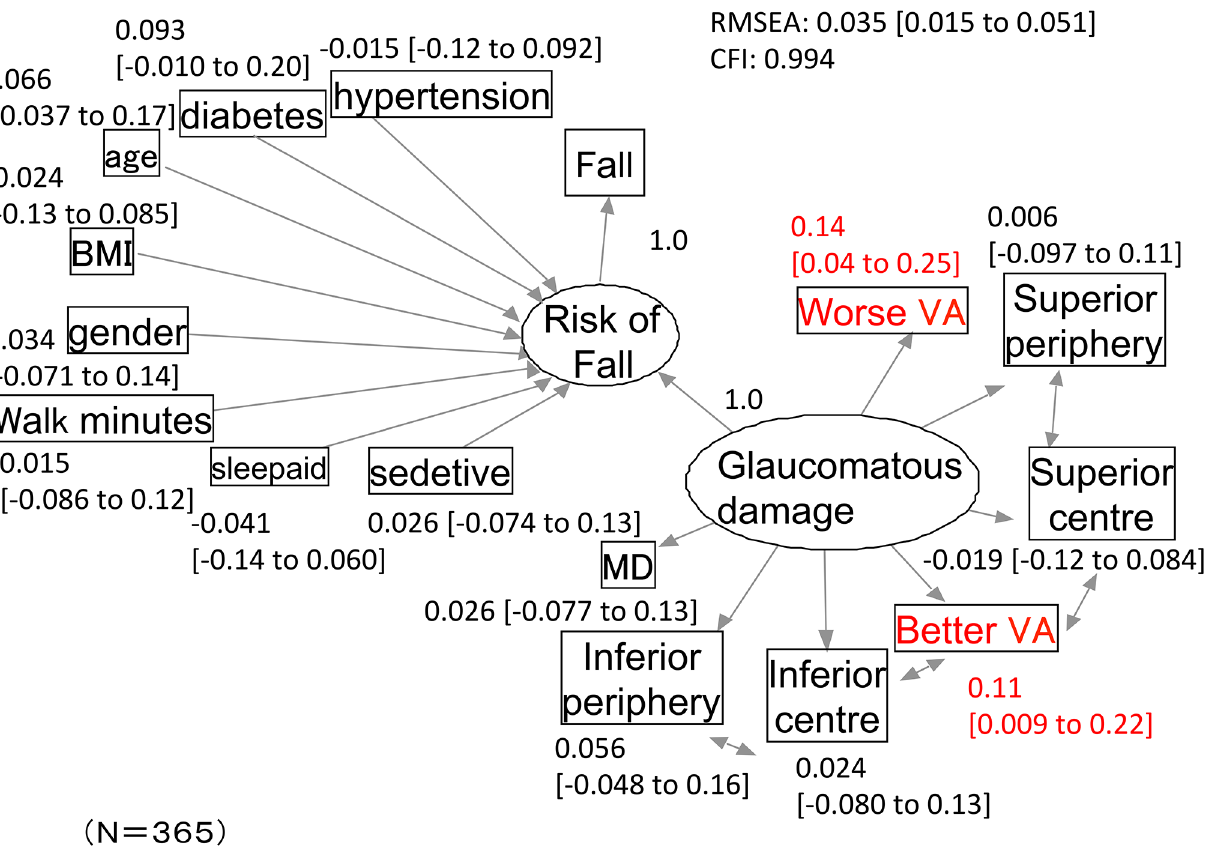
Fig 2. The structural equation modeling path diagram for the analysis of risk of falling. The model obtained an RMSEA of 0.035 and a CFI of 0.99. Among the 95% confidence intervals (CIs) of regression coefficients, only those from better-eye VA and worse-eye did not cross 0 (written in red). Variables in circles represent latent variables ( ‘ Glaucomatous Damage ’ and ‘ Risk of falling ’ ). Parentheses represent 95% CIs. BMI: body-mass index, gender: male: 0, female: 1, sleep aid: usage of sleep aid, sedative: usage of sedative. Superior peripheral, superior central, inferior central and inferior peripheral: means of the total deviation values in the superior peripheral, superior central, inferior central and inferior peripheral areas, respectively. MD: mean of the total deviation values in whole field. VA: visual